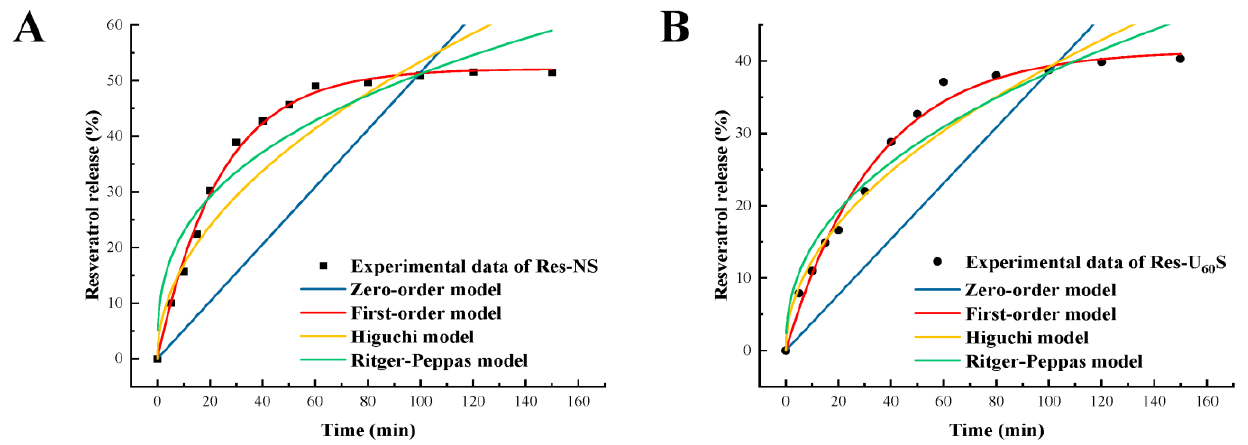
Figure 8. In vitro resveratrol-release profile from Res-NS ( A ) and Res-U 60 S ( B ) during intestinal digestion. Table 4. Fitting results of the kinetic-release model of resveratrol from Res-NS and Res-U 60 S.